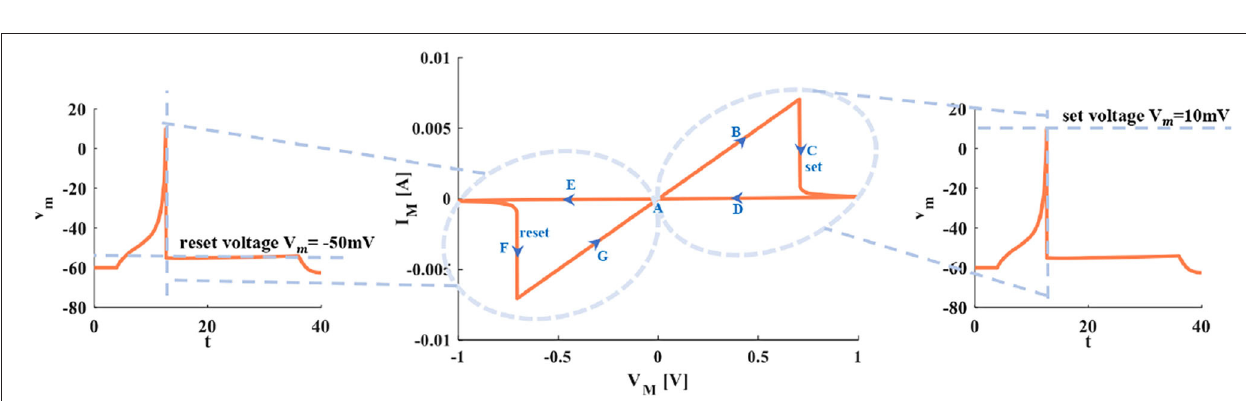
FIGURE 3 | The relationship between the I–V curve of the memristor and the action potential in the